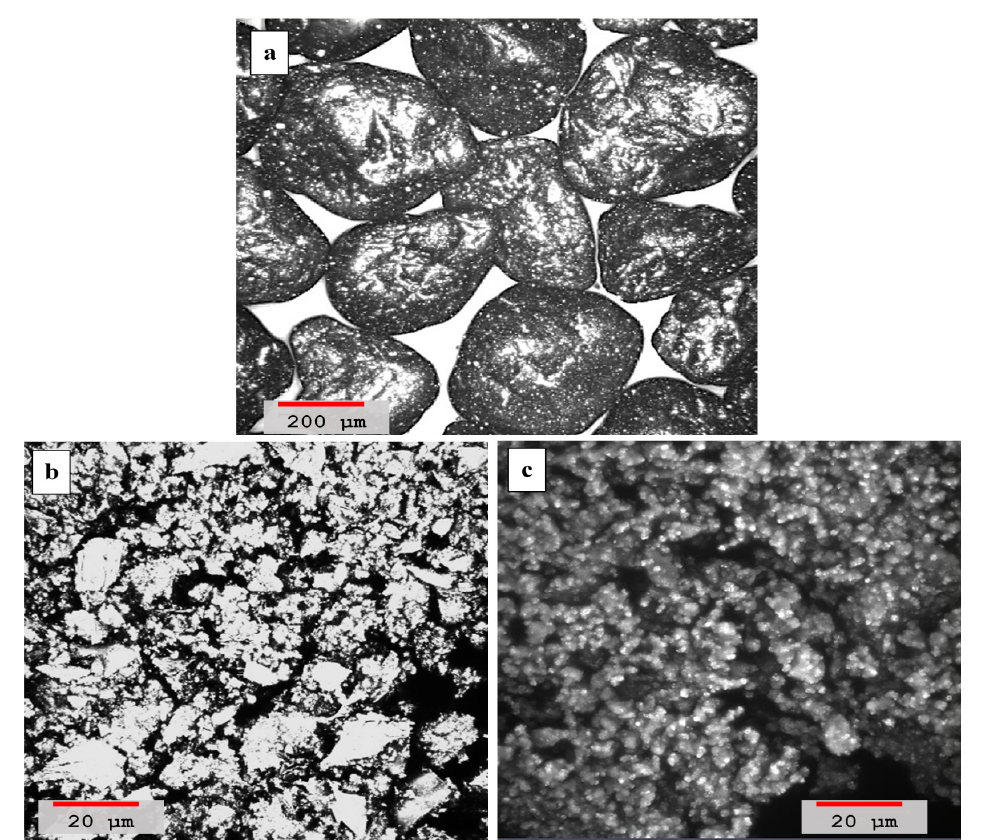
Figure 5. ( a ) Laser scanning microscopy image of grains of sand dunes. The red colored scale-bar in the left shows ≈ 200 µ m length. ( b ) Laser scanning microscopy image of flacks of volcanic ash. The red colored scale-bar in the left shows ≈ 20 µ m length. ( c ) Laser scanning microscopy image of the lime powder. The red colored scale-bar in the right shows ≈ 20 µ m length.